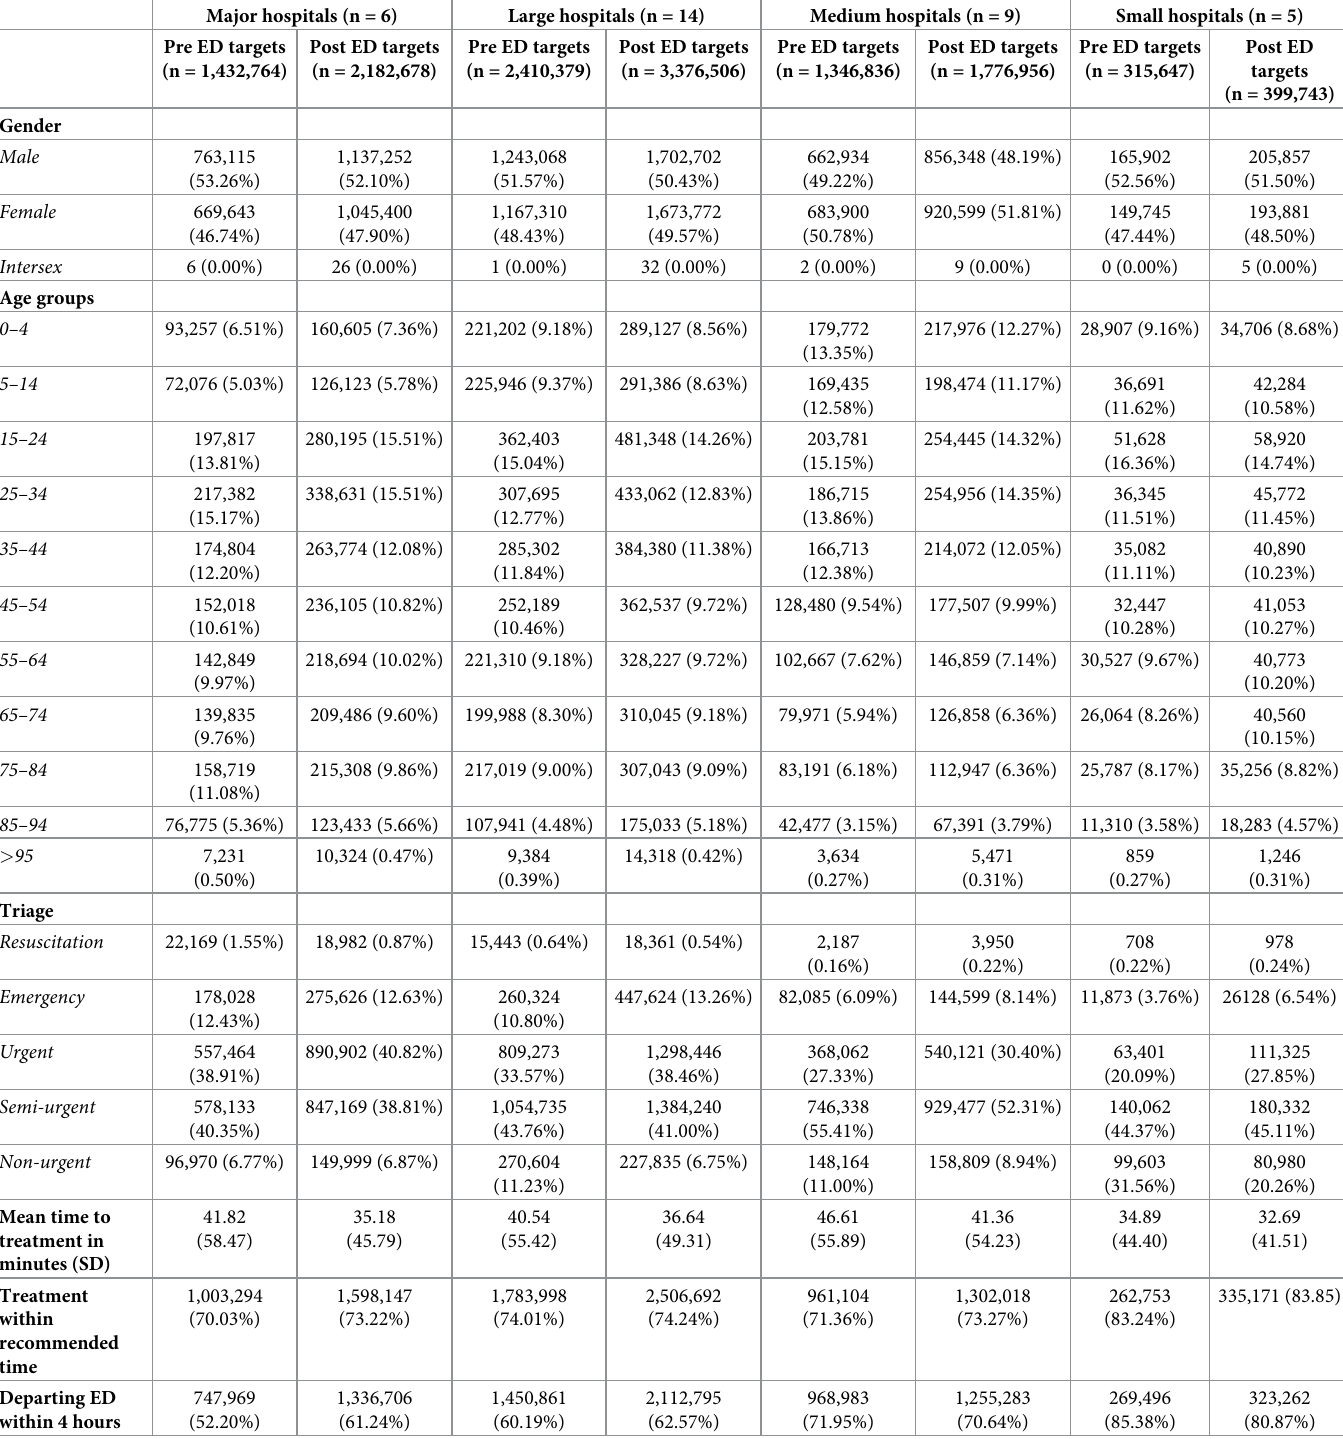
Table 1. Patients characteristics by hospital peer groups (N =